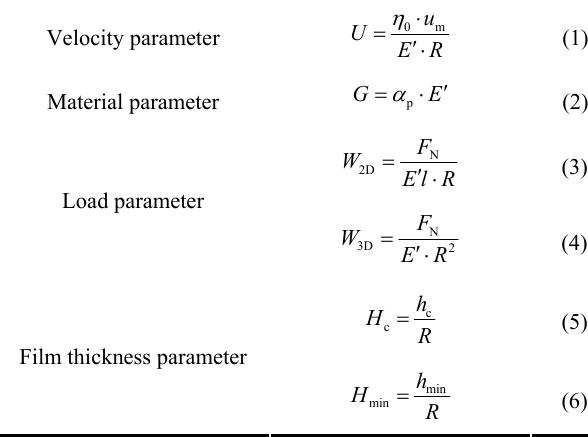
Table 1 Non-dimensional parameters according to Dowson/ Higginson [5, 6].